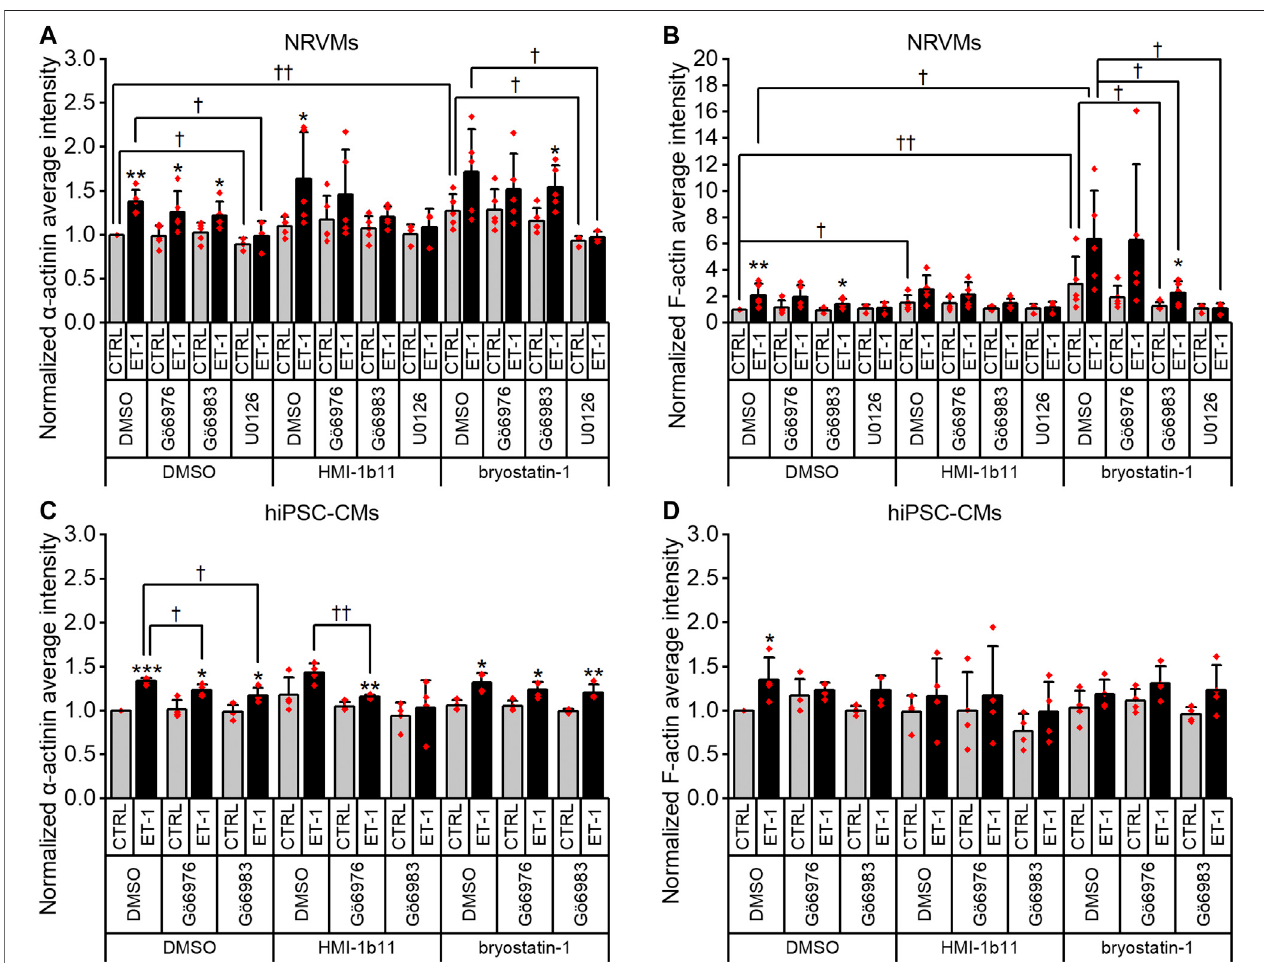
FIGURE 7 | Effects of endothelin-1 (ET-1) and pharmacological PKC modulation on the average intensity of α -actinin and F-actin in cardiomyocytes. Average intensity of α -actinin and F-actin in NRVMs ( A,B , respectively) and in hiPSC-CMs ( C,D , respectively) was measured after 48 h exposure to PKC activators (10 µM HMI- 1b11 and 10 nM bryostatin-1), cPKC inhibitor (1 µM Gö6976), pan-PKC inhibitor (1 µM Gö6983) and MEK1/2 inhibitor (10 µM U0126) with or without 100 nM ET-1. Resultsarenormalized toDMSO control and expressed asmean +SDofindependent experiments with CMsfrom individualcell isolations ordifferentiations (n (cid:2) 4 forhiPSC-CMs(D32-D49),n (cid:2) 5forNRVMsexceptforU0126n (cid:2) 3).*** p < 0.001,** p < 0.01,* p < 0.05forET-1vs.respectiveCTRL; †† p < 0.01, † p < 0.05asindicated (Univariate ANOVA followed by student ’ s t-test for independent samples for hiPSC-CMs, Kruskall-Wallis followed by Mann-Whitney U for NRVMs).